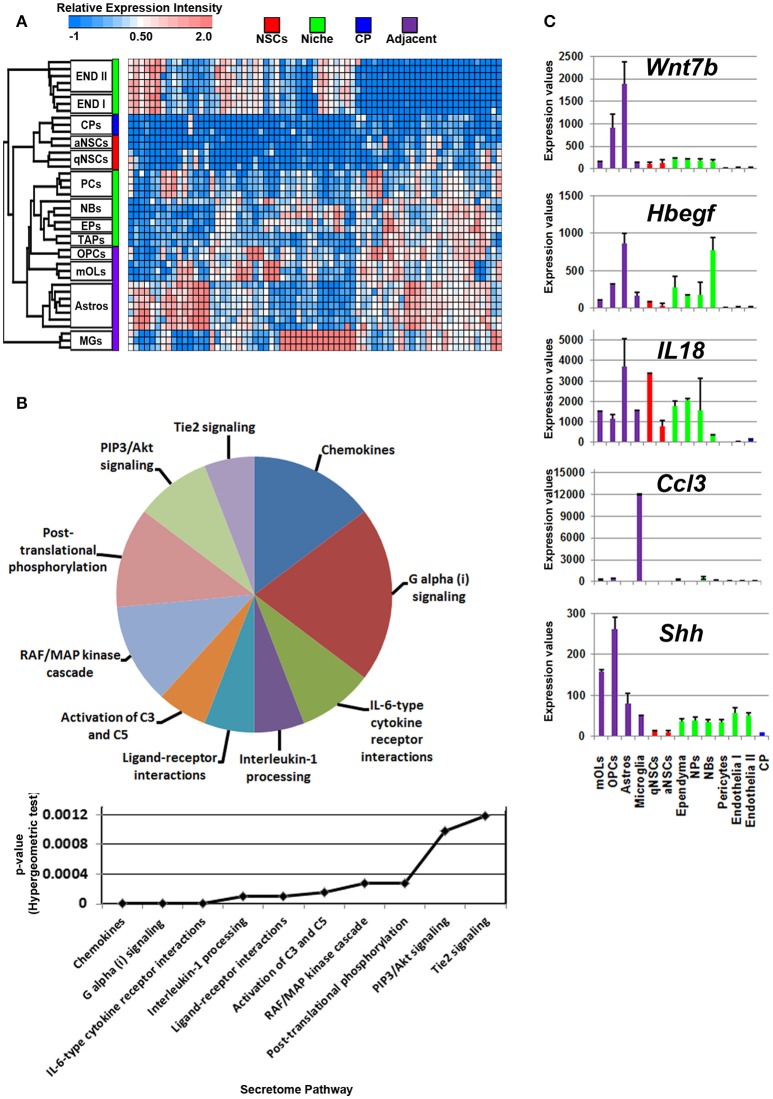
Enrichment of ligand mRNA derived from adjacent glial cells. (A) The transcriptome of ligands significantly (1.8 fold change; p < 5% FDR) enriched in subpopulations of glial cells are displayed as a heatmap and plotted with the remaining datasets. Ligands enriched in MGs are highly expressed in these cells compared to other cells types whereas those in astrocyte and oligodendroglia show some exclusiveness in their expression and some shared expression with other cells. (B) These were further characterized using Reactome Pathway for classifying broadly the functions and signaling networks of ligand mRNA detected in the analysis and their p-values plotted below as a histogram. (C) The top most enriched genes are shown in histograms with in their antilog expression values across multiple cell types showing overall elevated expression in different glial cells. Red, green, blue and purple colors used are for groups containing NSCs, niche, choroid plexus and adjacent glial cells, respectively. CP, choroid plexus; aNSCs, active neural stem cells; qNSCs, quiescent neural stem cells; MGs, microglia; OPCs, oligodendrocytes precursor cells; Astros, astrocytes; OLs, oligodendrocytes (mature); NBs, neuroblasts; TAPs, transiently amplifying progenitors; EPs, ependymal; PCs, pericytes; END I, Endothelia 1; END II, Endothelia 2.